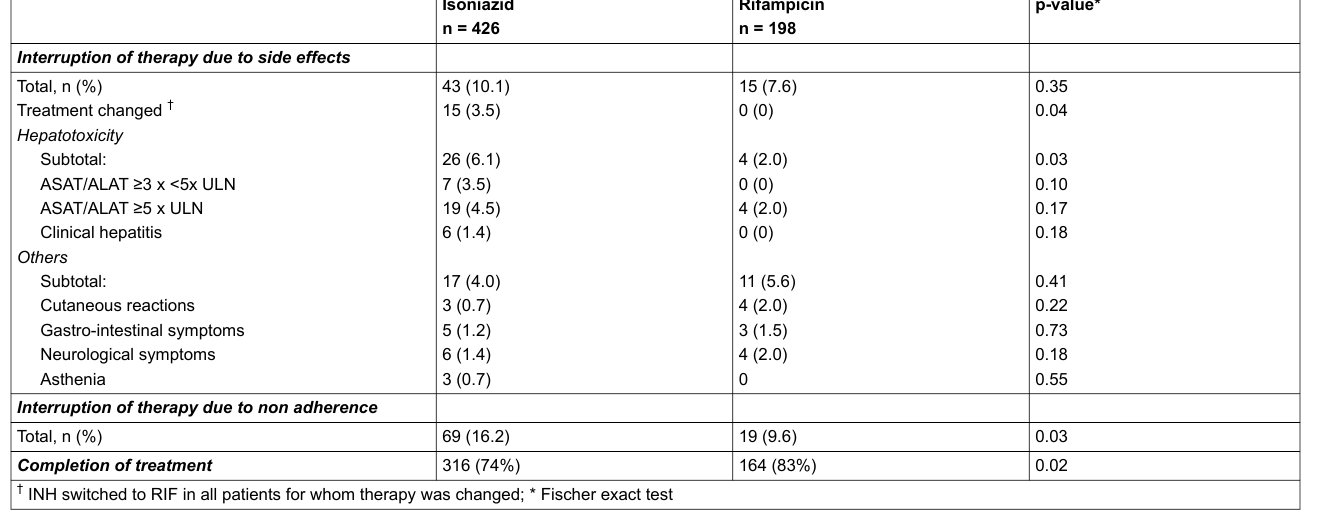
Table 2: Adverse events and outcome in patients with LTBI treated with INH or RIF.